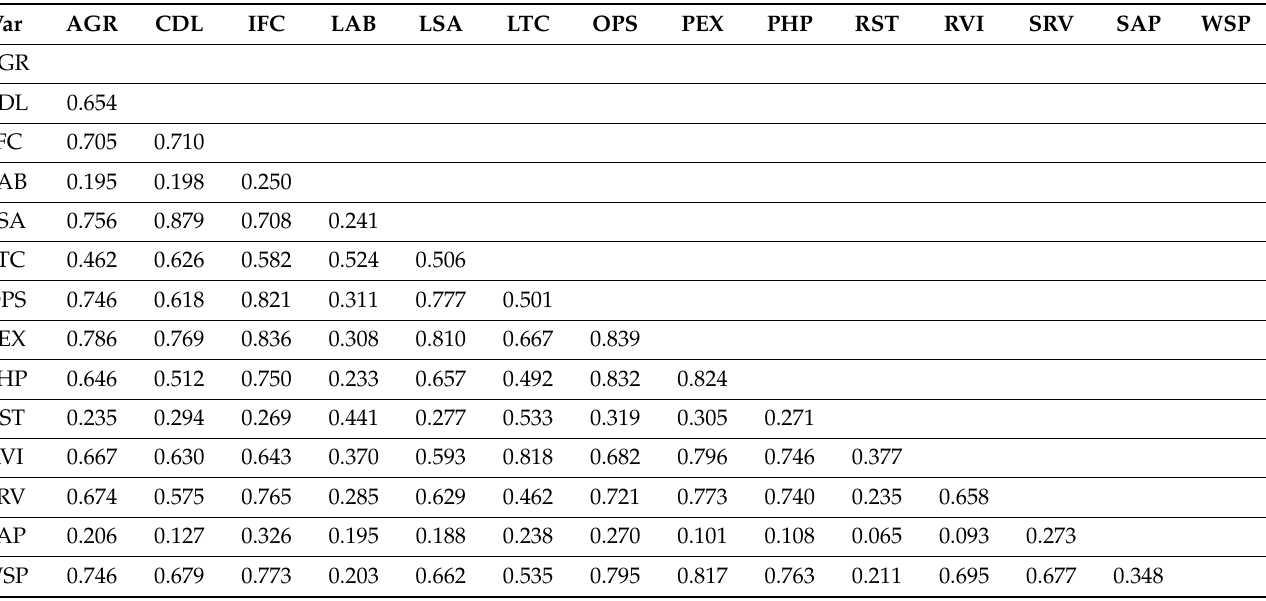
Table 5. Discriminant